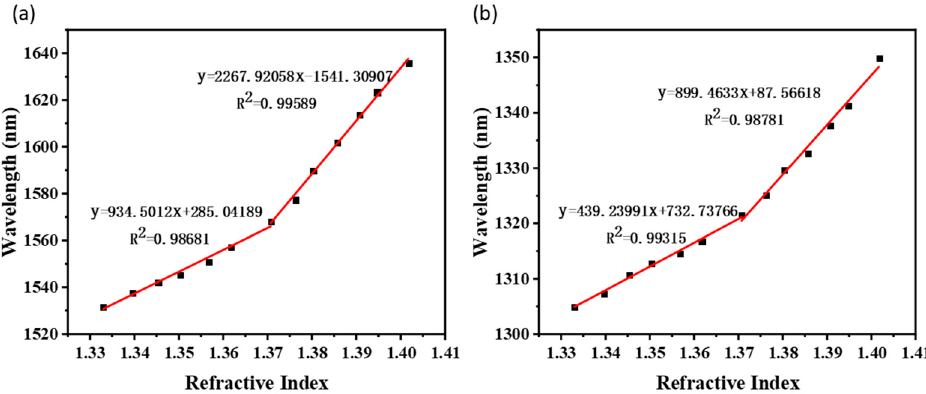
Figure 8. Linear fitting result of ( a ) the tape-in-taper fiber sensor with the second taper waist diameter of 25 µ m and ( b ) the single taper fiber sensor with the taper waist diameter of 25 µ m.